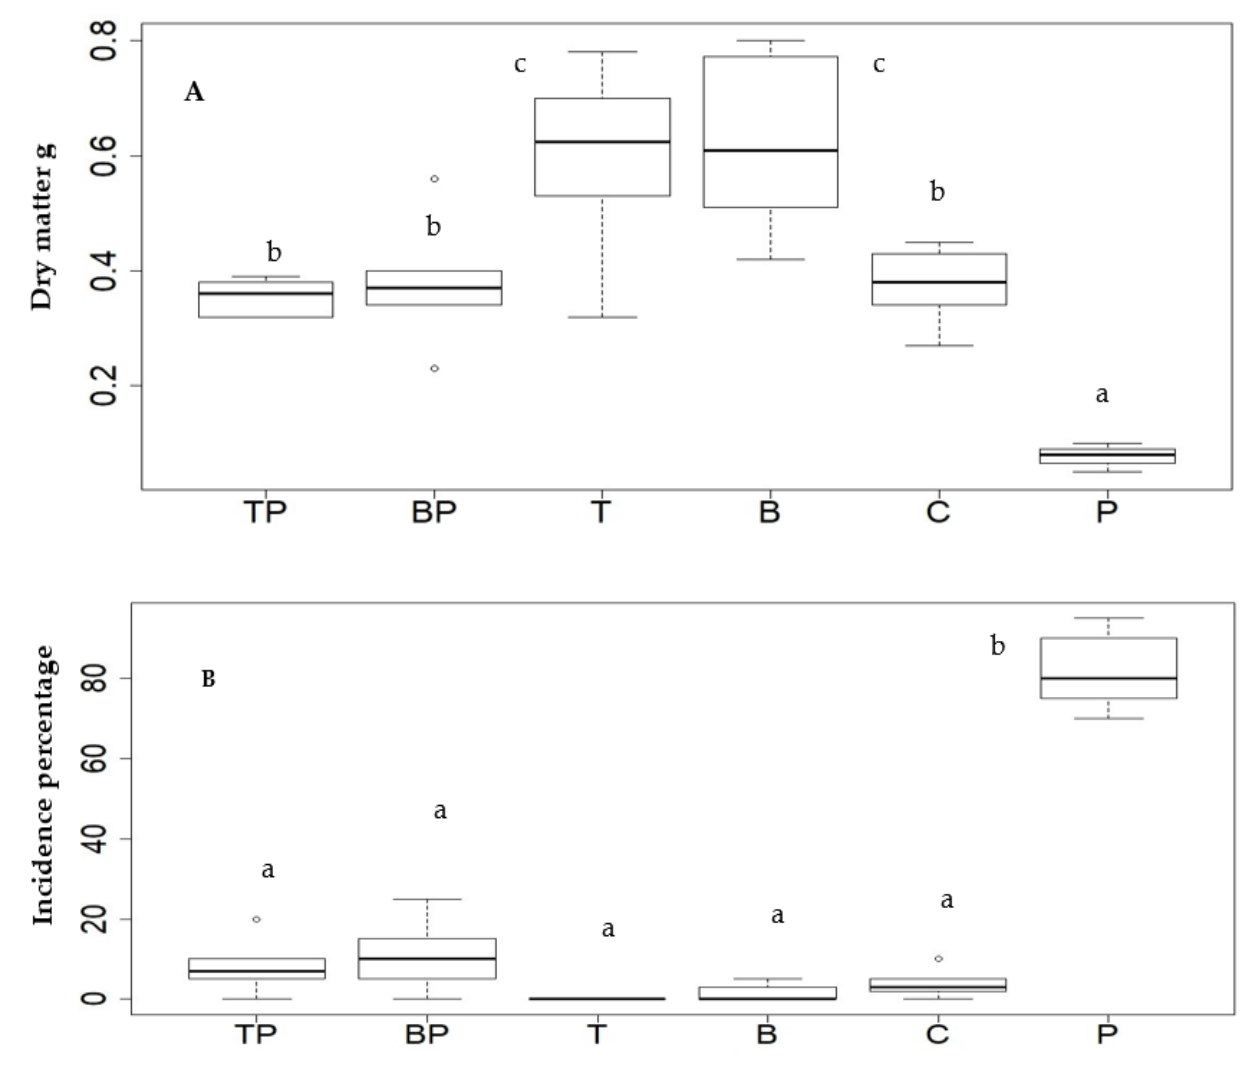
Figure 4. Effect of biotized M. spicata plantlets with B. subtilis and T. asperellum . Box and whisker plots on dry biomass ( A ) and the incidence of Rhizoctonia sp. ( B ). The treatments were: TP with endophyte T. asperellum + Rhizoctonia sp.; BP Plants with endophyte B. subtilis + Rhizoctonia sp.; T, mint plants with T. asperellum endophyte without pathogen; B. Plants with B. subtilis endophyte without pathogen; C, mint plants without endophyte (control); P, mint plants with Rhizoctonia sp. The data correspond to the means of 30 experimental units per treatment. Different letters indicate significant differences between treatments according to Tukey’s test at p < 0.05.